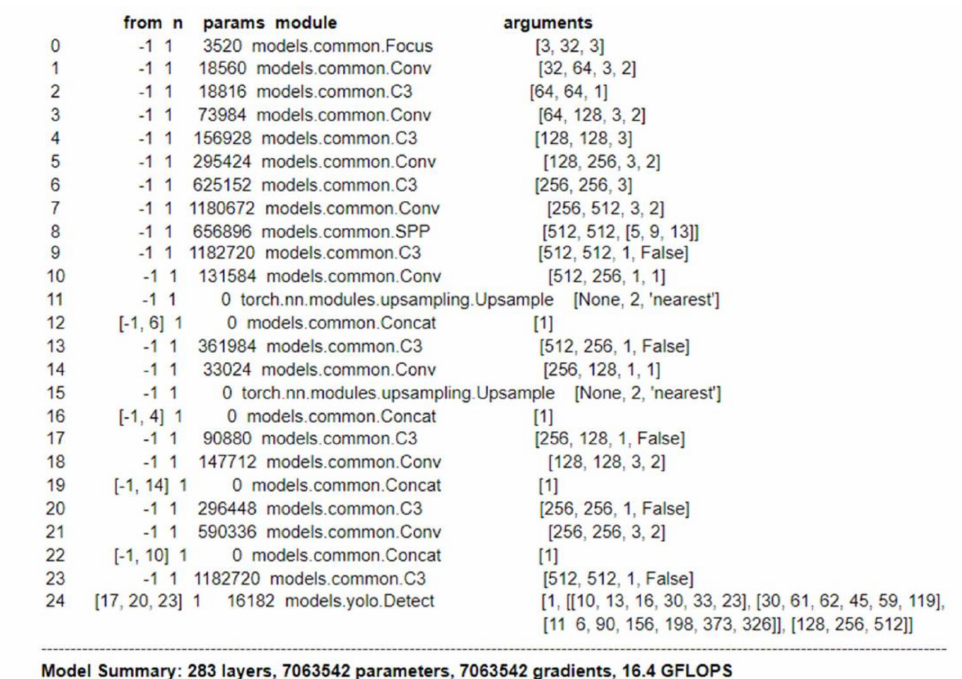
Figure 1. Architecture of